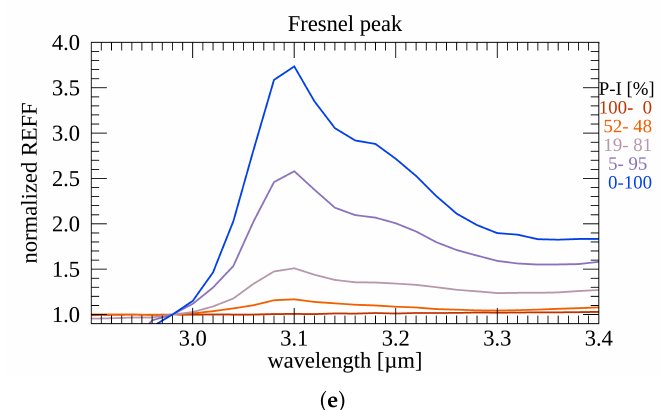
Figure 7. Water-ice-related absorption features ( a – d ) and Fresnel peak ( e ) for water ice–pyrrhotite 25–50 intimate mixtures. Absorption bands are plotted after continuum-removal (the black dashed line in each plot indicates the continuum- removed baseline), while the Fresnel peak region is shown after normalization at 2.98 µ m. Pyrrhotite (P) and water ice (I) mass fractions are